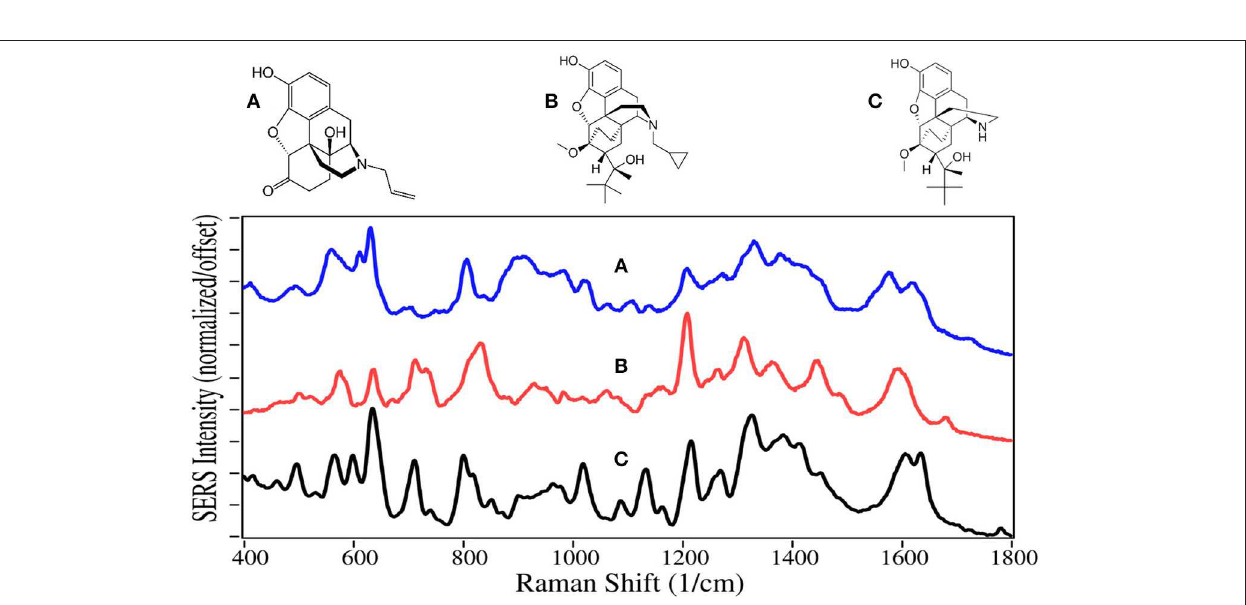
breathing modes at 1,000 and 1,025–1,035 cm − 1 , and to some extent the trigonal phenyl ring breathing mode at 1,595–1,600 cm − 1 ( Figure 5 ) (Dollish et al., 1974; Carter et al., 2000). All three drugs have a peak at 910–915 cm − 1 due to CNC stretching (Stanley, 2014). The same assignments have been given for SERS of methadone, except for the 1,660 cm − 1 peak, which